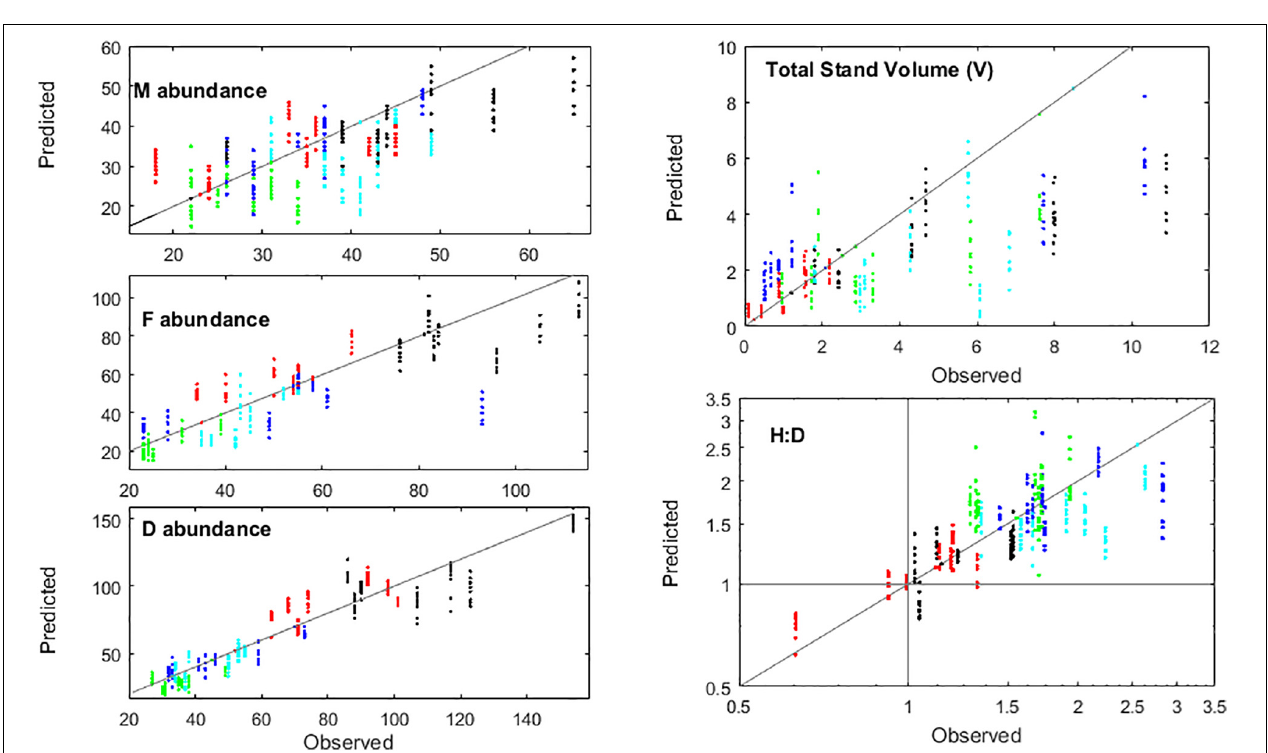
FIGURE 7 | Effect of the age-structure of the population on the haploid-to-diploid ratio (H:D): (A) HD of the recruits (i.e., imposed as forcing function) and the resulting population H:D simulated by the IBM. The gray line represents the 1:1 match. (B) H:D evolution with age of the cohort.